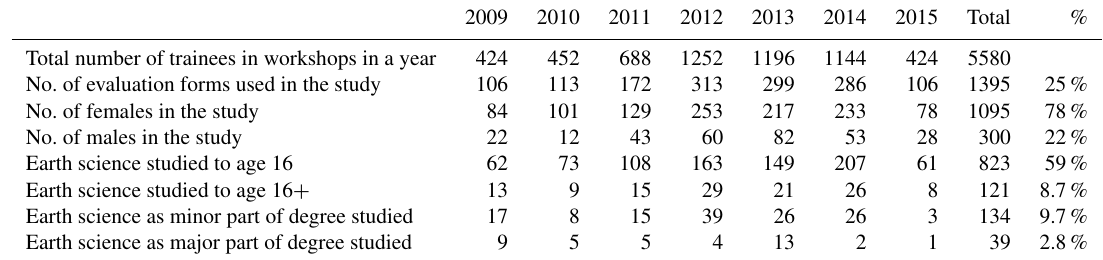
Table 1. Compilation background data of primary trainee teachers taken from the data on the ESEU evaluation forms collected during 2009–2015.